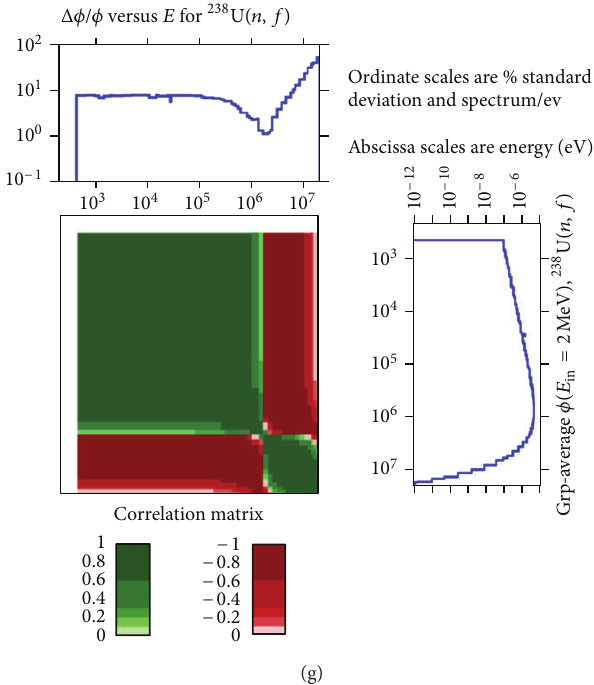
F 5: Covariance plot